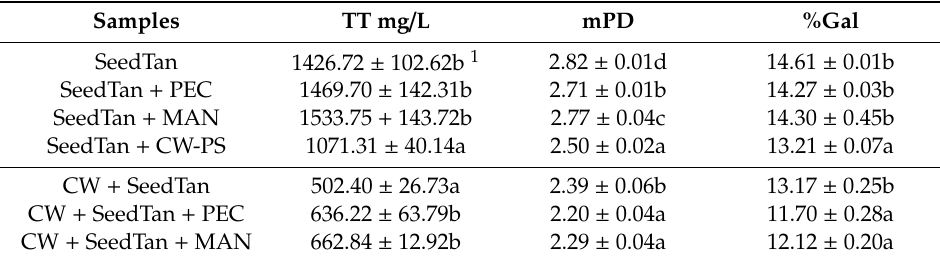
Table 2. E ff ect of the addition of soluble polysaccharides on the interaction between seed tannins and cell walls. Characterization and quantification of tannins in